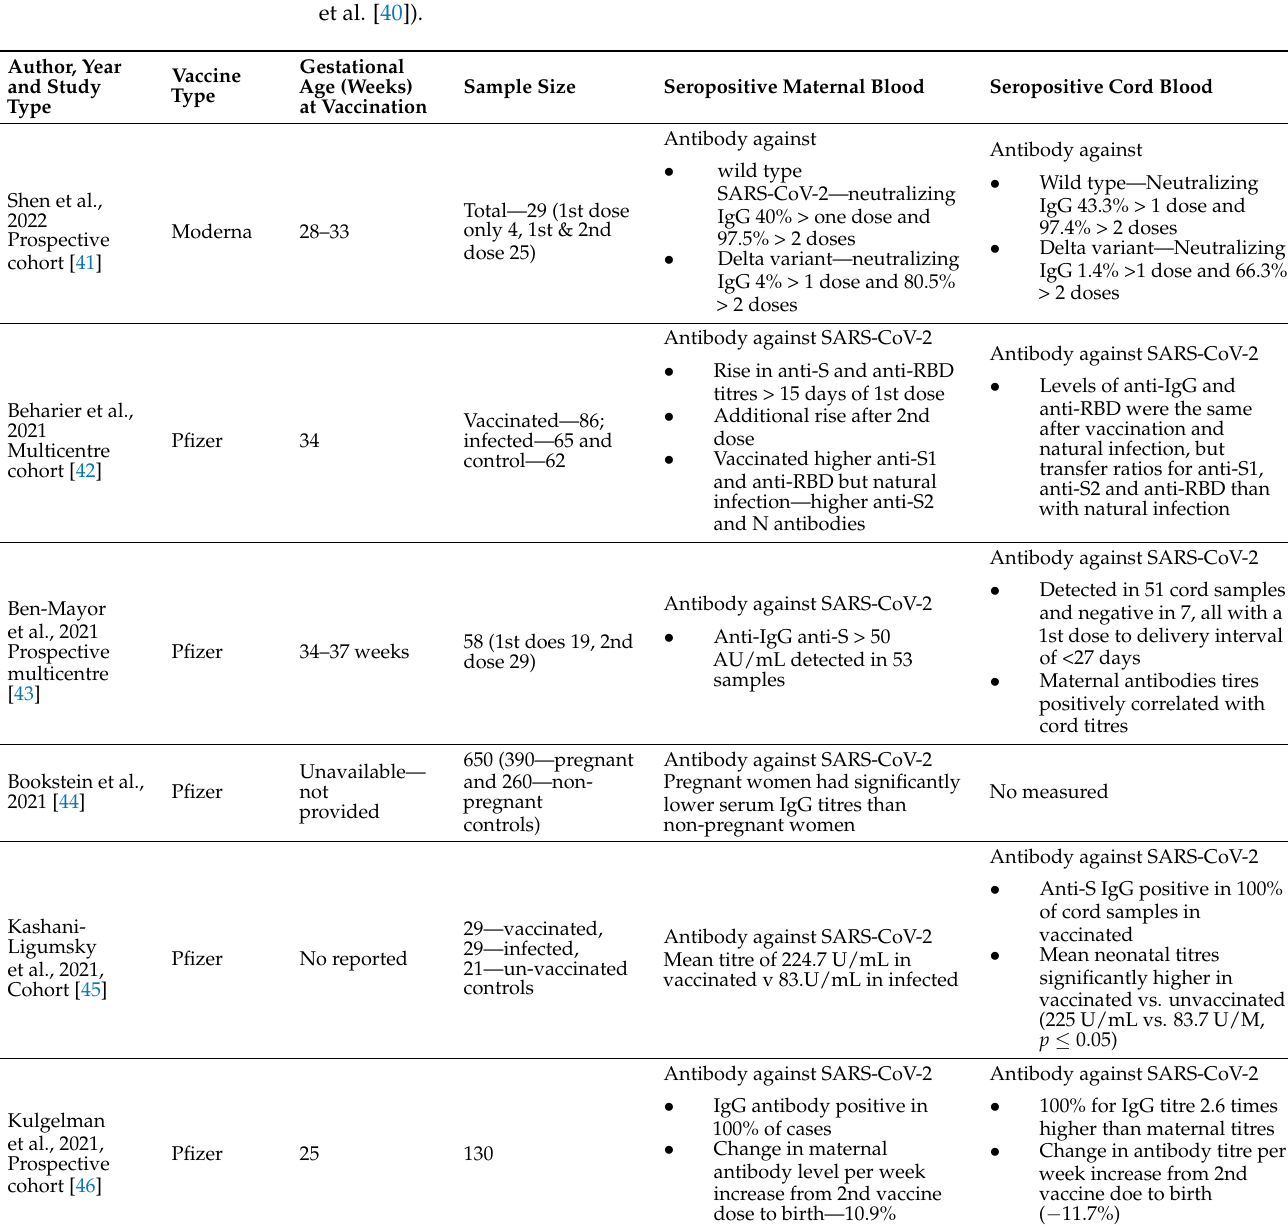
Table 2. Evidence of immunoreactivity from published studies in pregnancy (adapted from Badell et al.